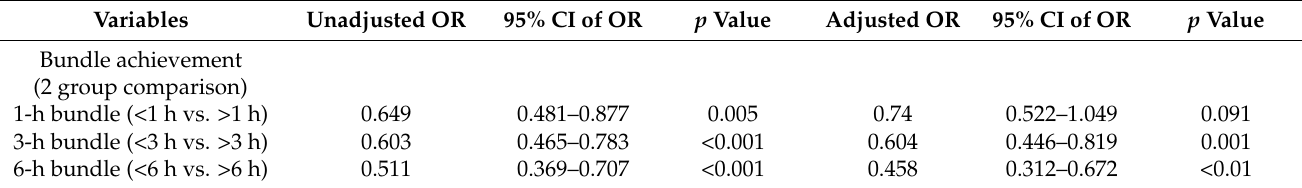
Table 2. Univariate and multivariable logistic regression analysis for in-hospital